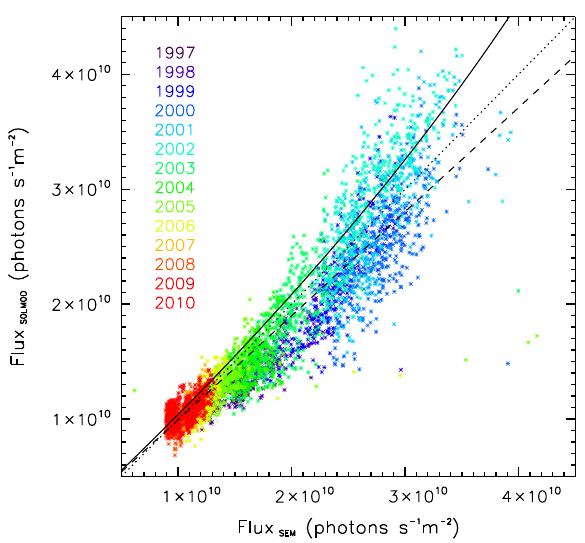
Fig. 9. Regression analysis of the SOLMOD reconstruction versus the SOHO/SEM data. The colors indicate the data point for the calendar years throughout the time series. The solid black line shows the second-order polynomial fit, and the dashed line gives the linear component of the fit with a correlation coefficient r 2 = 0.82. The dotted line indicates the diagonal for better